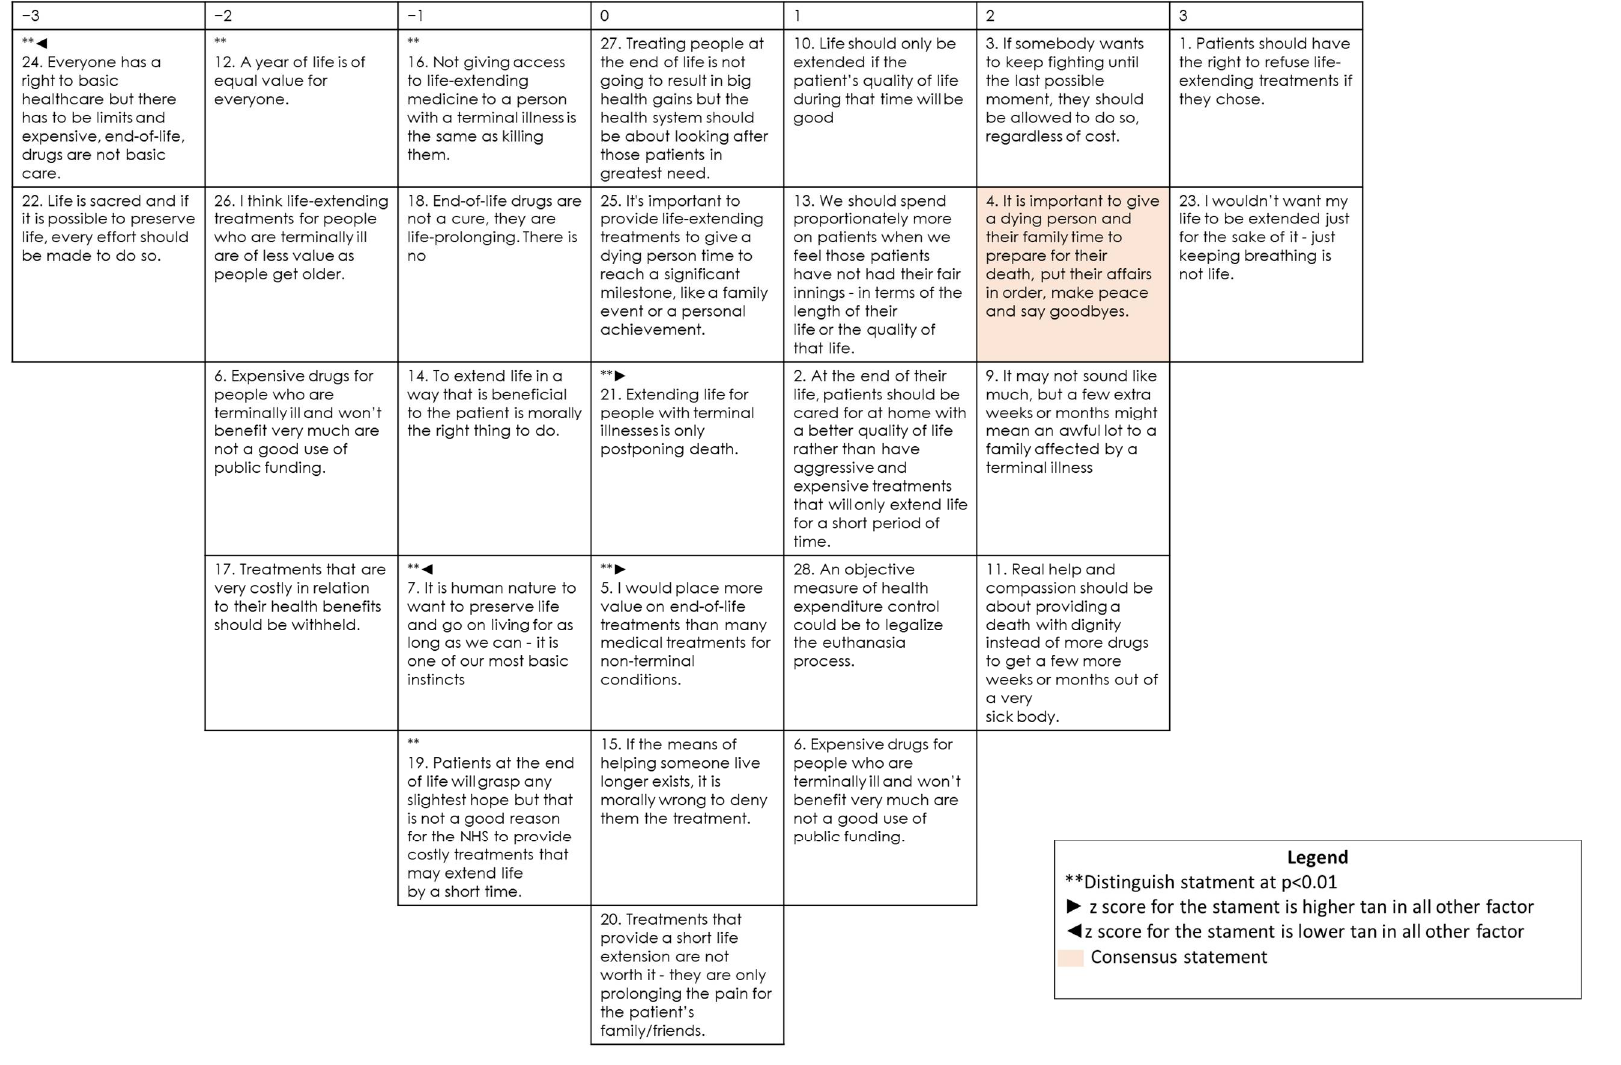
Figure 1. Composite Q sort for factor 1.